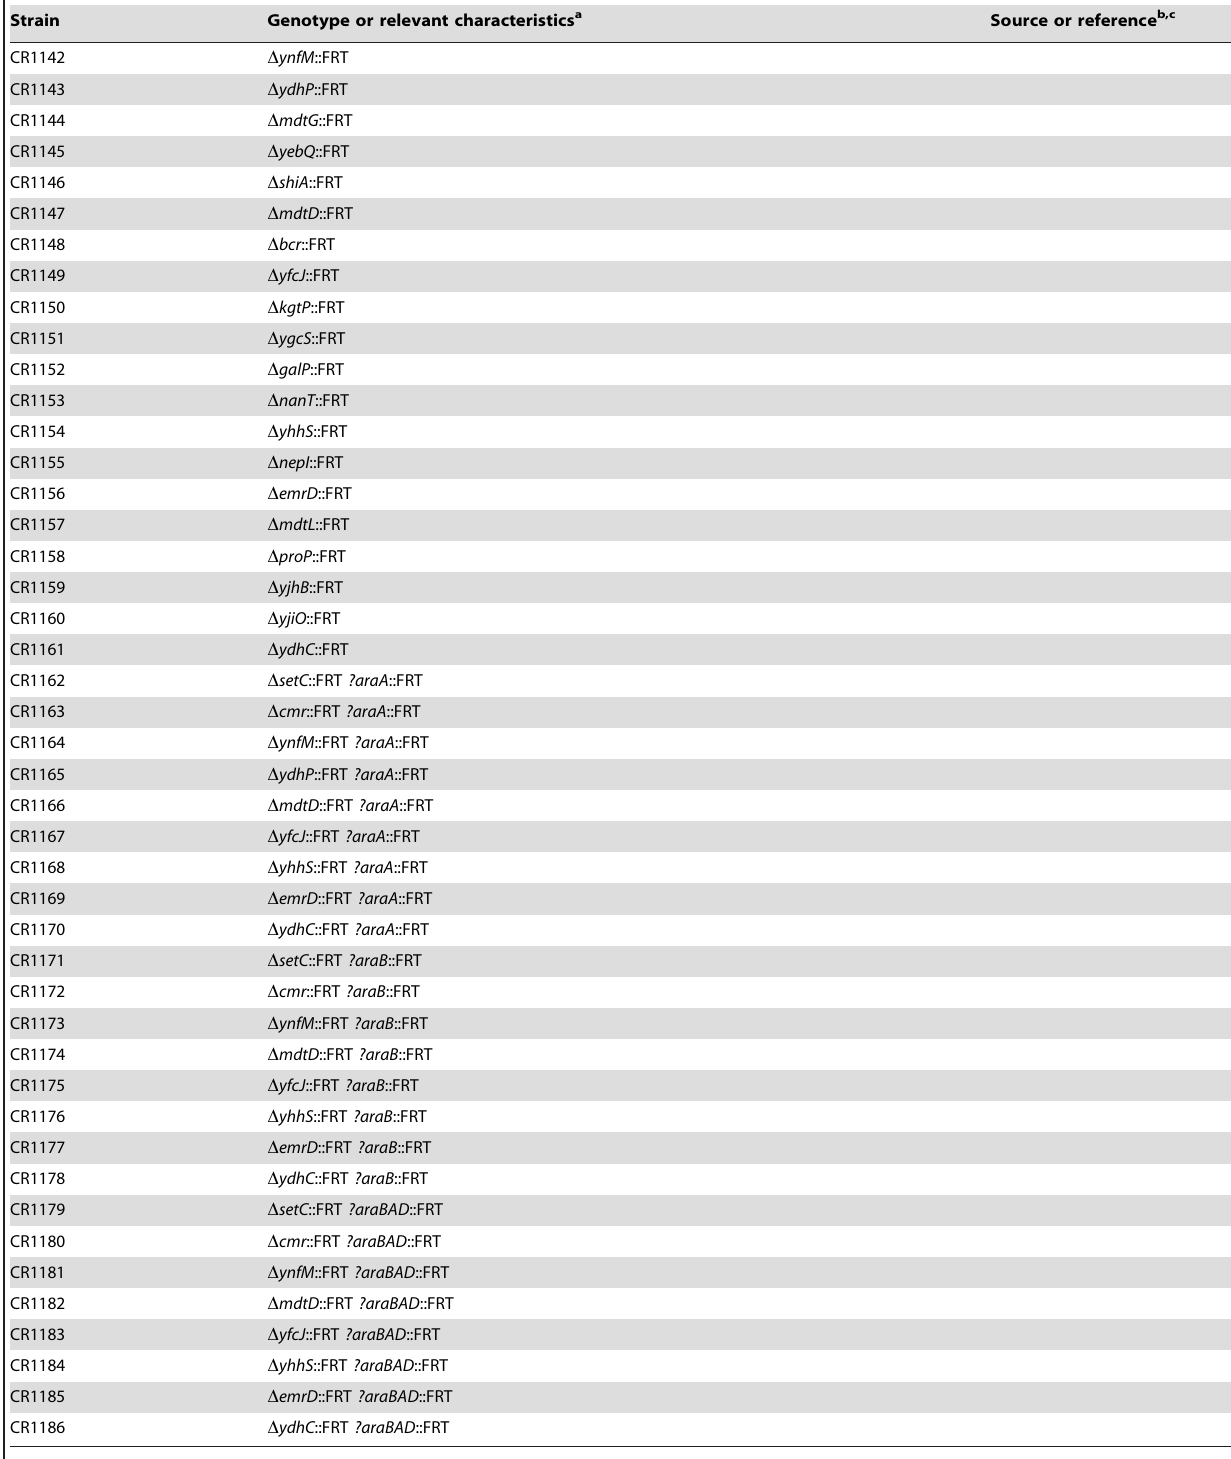
Strain Genotype or relevant characteristics a Source or reference